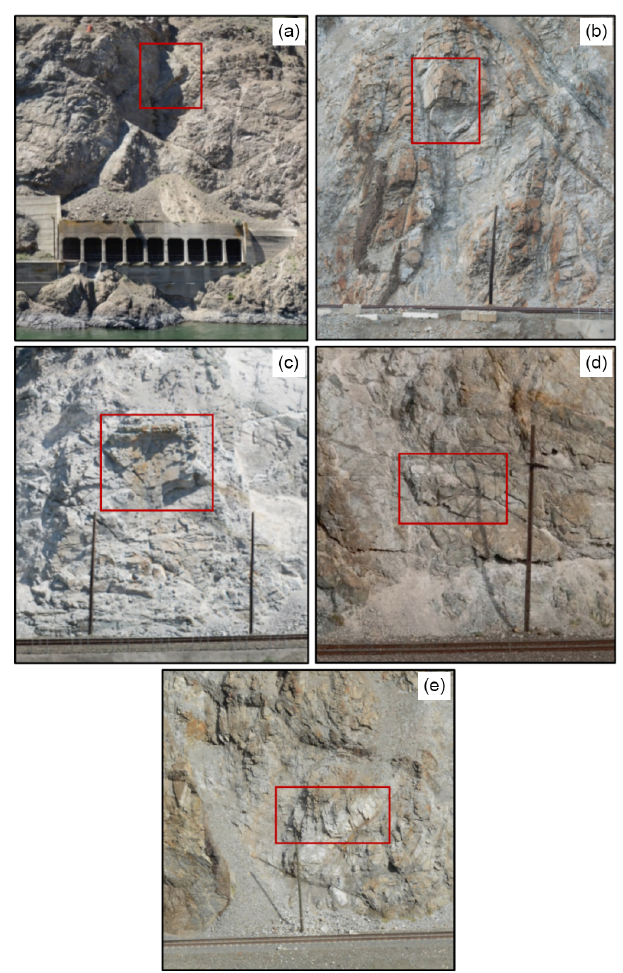
Figure 2. Photos of five rock slope sections, prior to failure, from the Goldpan (a) and White Canyon (b–e) sites adjacent to the CN Railway. The red regions indicate the source zone for the rockfall events discussed in this